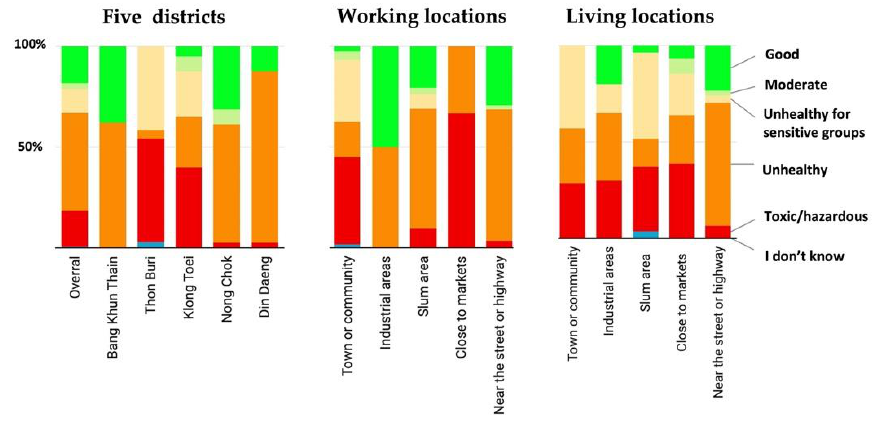
Figure 3. Socio-economic groups’ perceptions of urban air quality (N = Figure 3. Socio- economic groups’ perception s of urban air quality (N = 400).